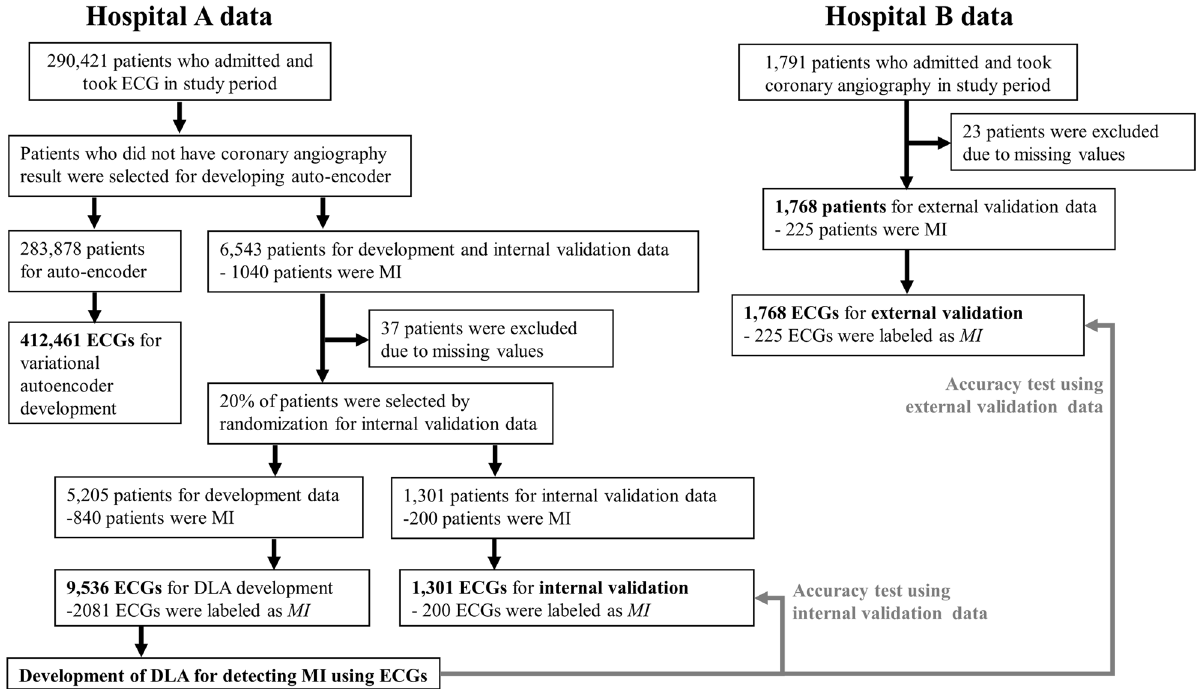
Figure 1. Study flowchart. DLA deep learning-based algorithm, ECG electrocardiography, MI myocardial